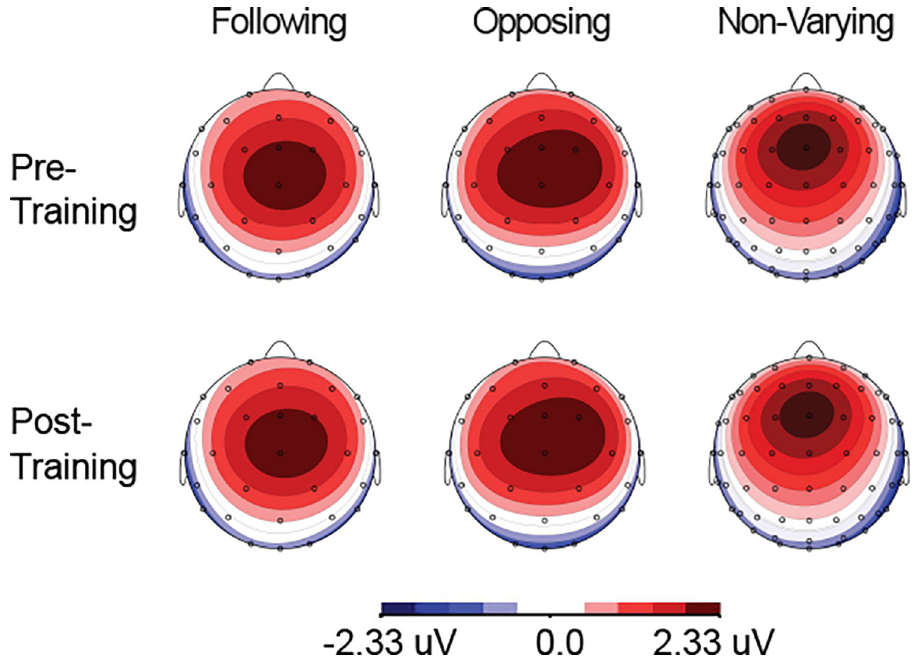
Fig 2. Mapping view of the P2 response. Mapping view of the grand averaged ERPs from 210–250 ms pre-training (top row) and 210–250 ms post-training (bottom row) for the opposing, following, and non-varying groups.